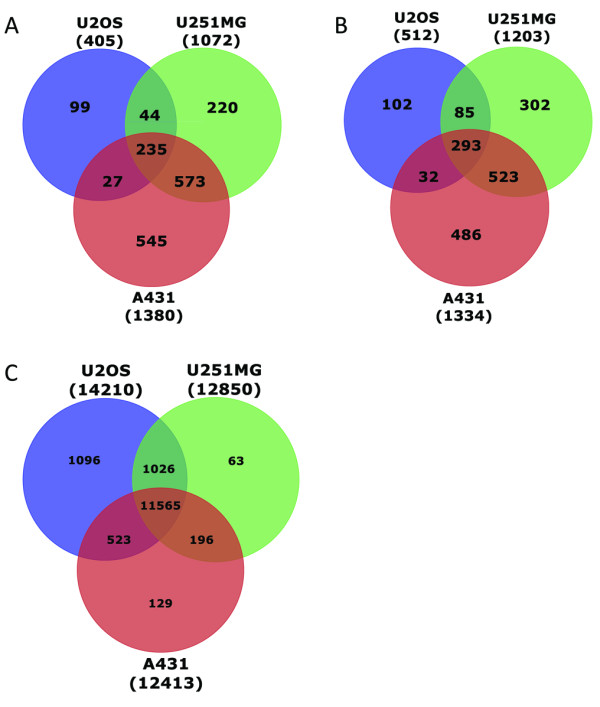
Number of differentially detected genes between the preparation methods for each cell line. A: Genes detected at a significantly higher level (A), lower level (B) or with no difference (C) in total RNA compare to cytoplasmic RNA. The percentages of differentially detected genes were: A-431 18%, U-251MG 15%, and U-2 OS 6%; calculated as the sum of genes at a higher and lower level divided by the total number of detected genes.